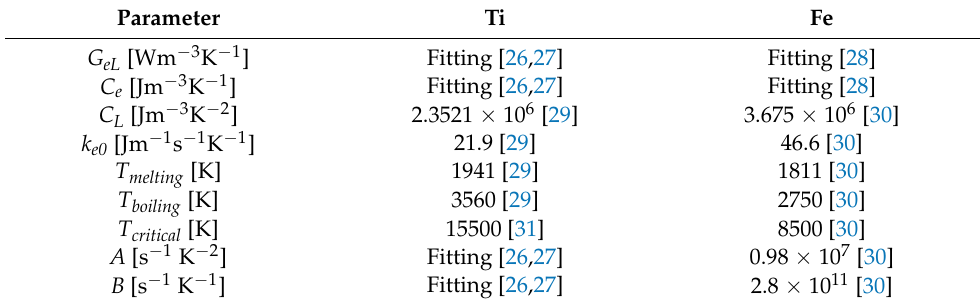
Table 3. Simulation parameters for Ti and